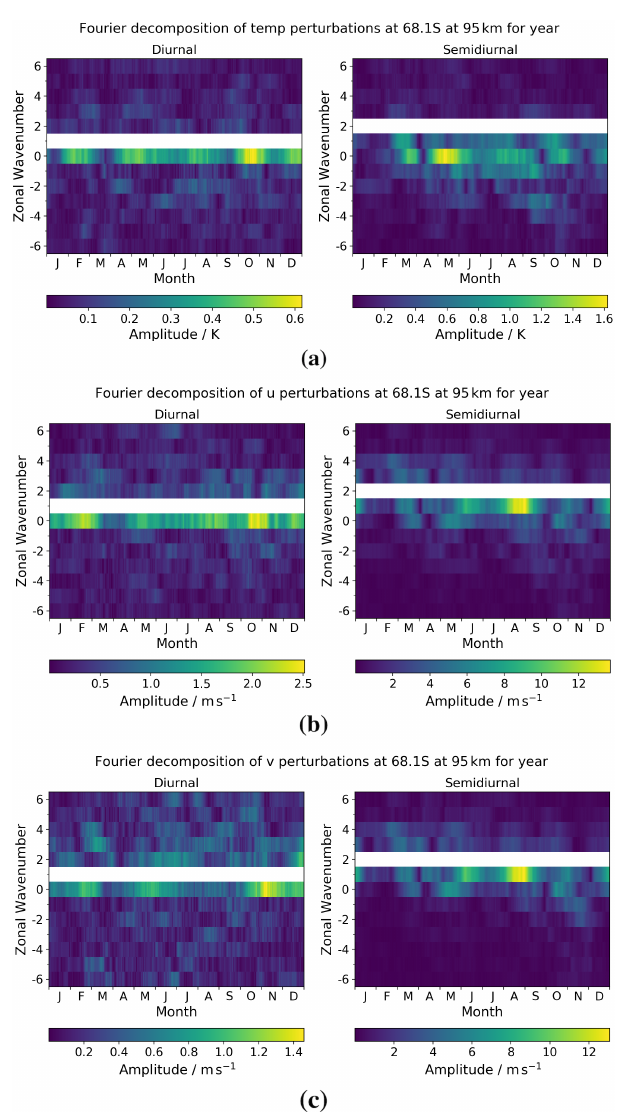
Figure 11. Diurnal and semidiurnal tidal amplitudes as a function of month and zonal wavenumber at the polar latitude of Rothera (68 ◦ S) for (a) temperature, (b) zonal ( u ) winds, and (c) meridional ( v ) winds. The dominant migrating tidal component is removed in each case for